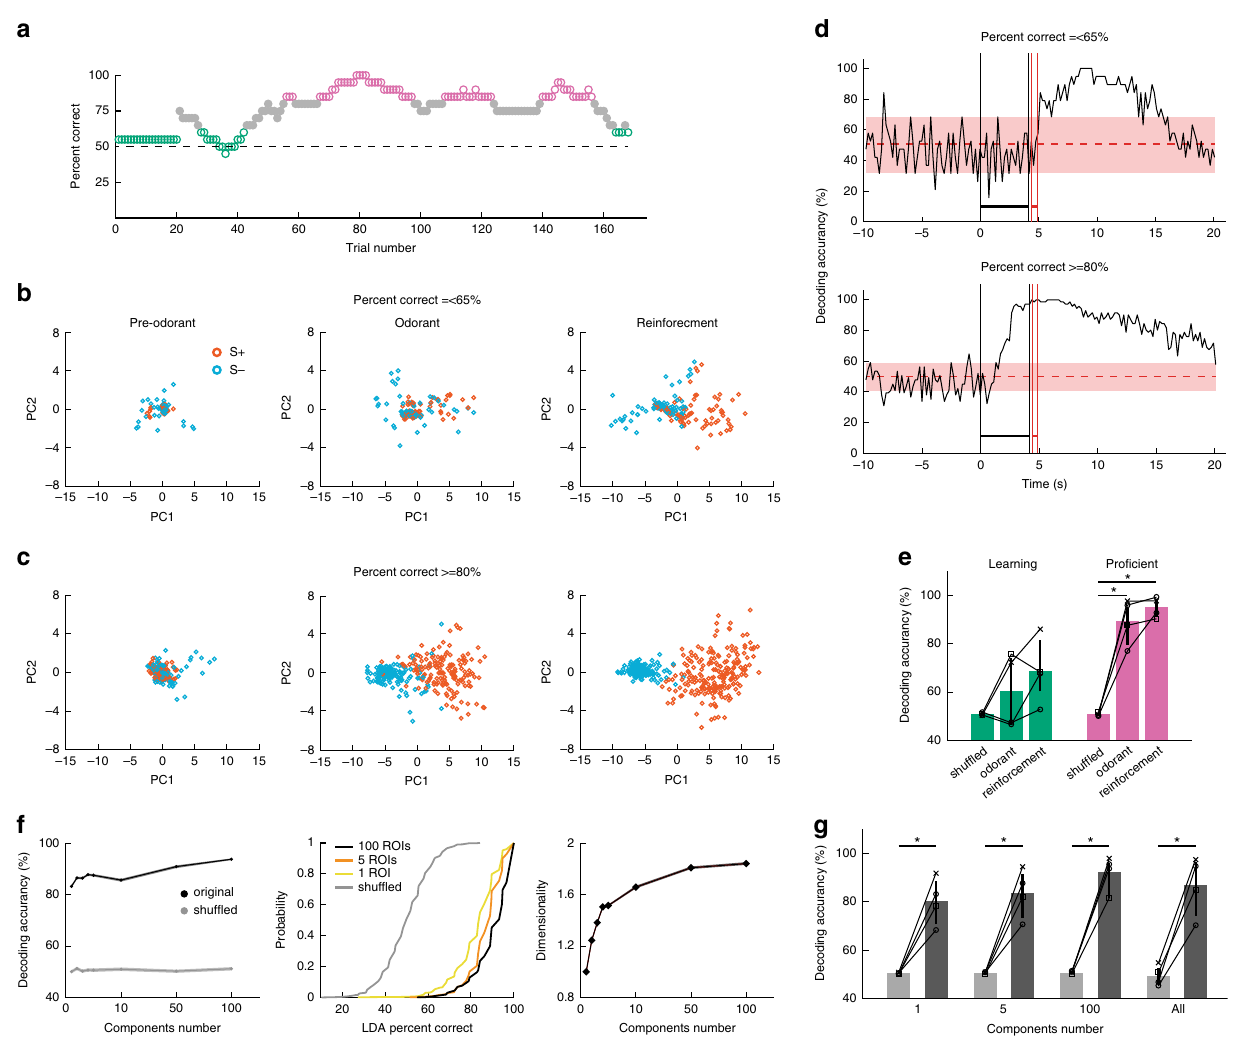
Fig. 3 Stimulus decoding accuracy increases as the animal learns to discriminate odorants. a – d Show behavioral performance ( a ), PCA analysis ( b , c ) and LDA analysis ( d ) for one session (one mouse). a Learning curve for a mouse performing the head- fi xed go – no go task. Magenta dots: pro fi cient level ( ≥ 80% percent correct), green dots: percent correct ≤ 65%. n = 20 trials within a sliding window. b , c First two principal components for the PCA for the changes in GCaMP6f fl uorescence ( Δ F / F ) in all the ROIs in the FOV. b The mouse was performing ≤ 65% correct, c the same mouse was performing ≥ 80% correct. The principal components are shown for three time periods: Pre-odorant: 1 s before odorant addition, odorant: 1 s before removal of the odorant, and Reinforcement: 1.5 s after reward. Orange circles: S + trials, light blue circles: S − trials. d Decoding accuracy for the linear discriminant analysis (LDA) trained to predict odorant identity using Δ F / F for all ROIs in the FOV. Shade: 95% CI for LDA trained with shuf fl ed odorant identity (line = 50%). The vertical black lines are odorant onset and removal and the red lines bound the reinforcement period. e Average LDA decoding accuracy (mean ± 95% CI) calculated from the ( Δ F / F ) for all ROIs in the FOV from data recoded in four mice. A GLM analysis of decoding accuracy yielded statistically signi fi cant interactions between (shuf fl ed vs. odorant) × (pro fi cient vs. naive) and for (shuf fl ed vs. reinforcement) × (pro fi cient vs. naive) (GLM p values <0.01 and <0.05, 24 observations, 18 d.f., n = 4 sessions, 4 mice, GLM F-statistic = 16.4, p < 0.001). *Post-hoc two-sided t tests corrected for multiple comparison using the false discovery rate (FDR, p < pFDR = 0.007, n = 4 sessions, 4 mice). f Example of LDA decoding analysis performed with subsets of ROIs ranging from 100 to 1 ROI. The analysis was performed for one session for trials where the mouse was pro fi cient (percent correct ≥ 80%). Left: Decoding accuracy (mean ± 95% CI) as a function of the number of ROIs. Center: Cumulative probability histograms for the decoding accuracy for the different number of ROIs and for the shuf fl ed LDA. Right: Dimensionality as a function of the number of ROIs. g Summary graph showing the average decoding accuracy for different numbers of ROIs (mean ± 95% CI, 4 sessions, 4 mice). A GLM analysis indicated that the decoding accuracy for the shuf fl ed analysis was statistically different from accuracy with the subsets of ROIs ( p < 0.001, 72 observations, 54 d.f., n = 4 sessions, 4 mice, GLM